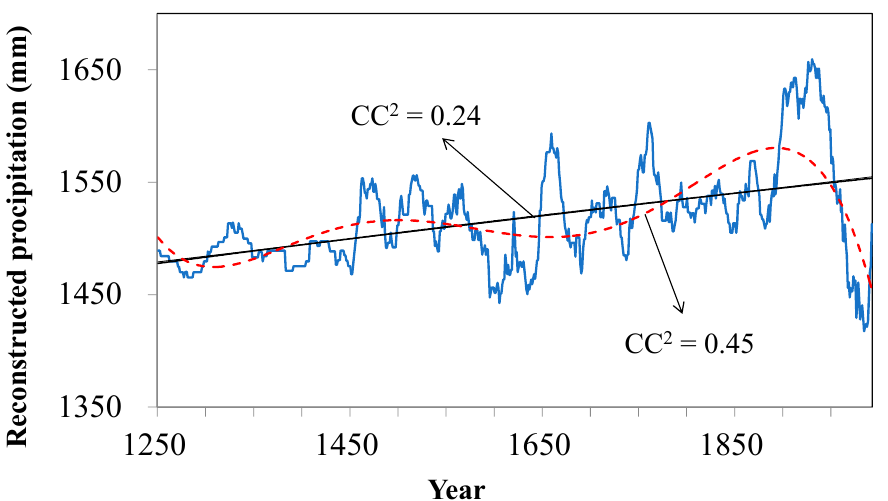
Figure 4. Precipitation 25-year moving average (blue curve), linear fit (black line) and polynomial fitting (red curve), nearly eight hundred years in Wuzhou City.